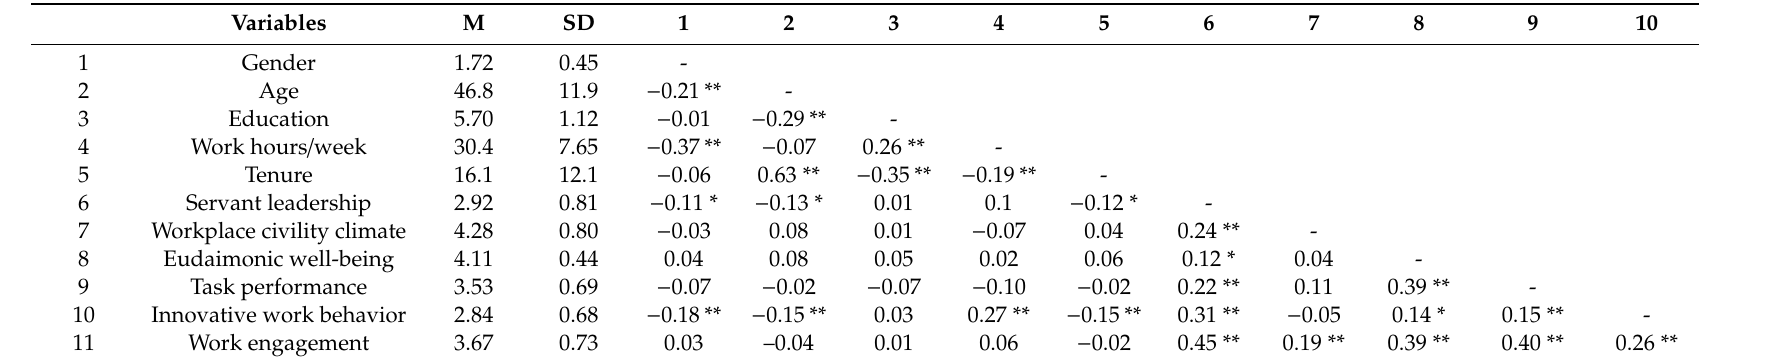
Table 1. Means, standard deviations, and correlations for all study